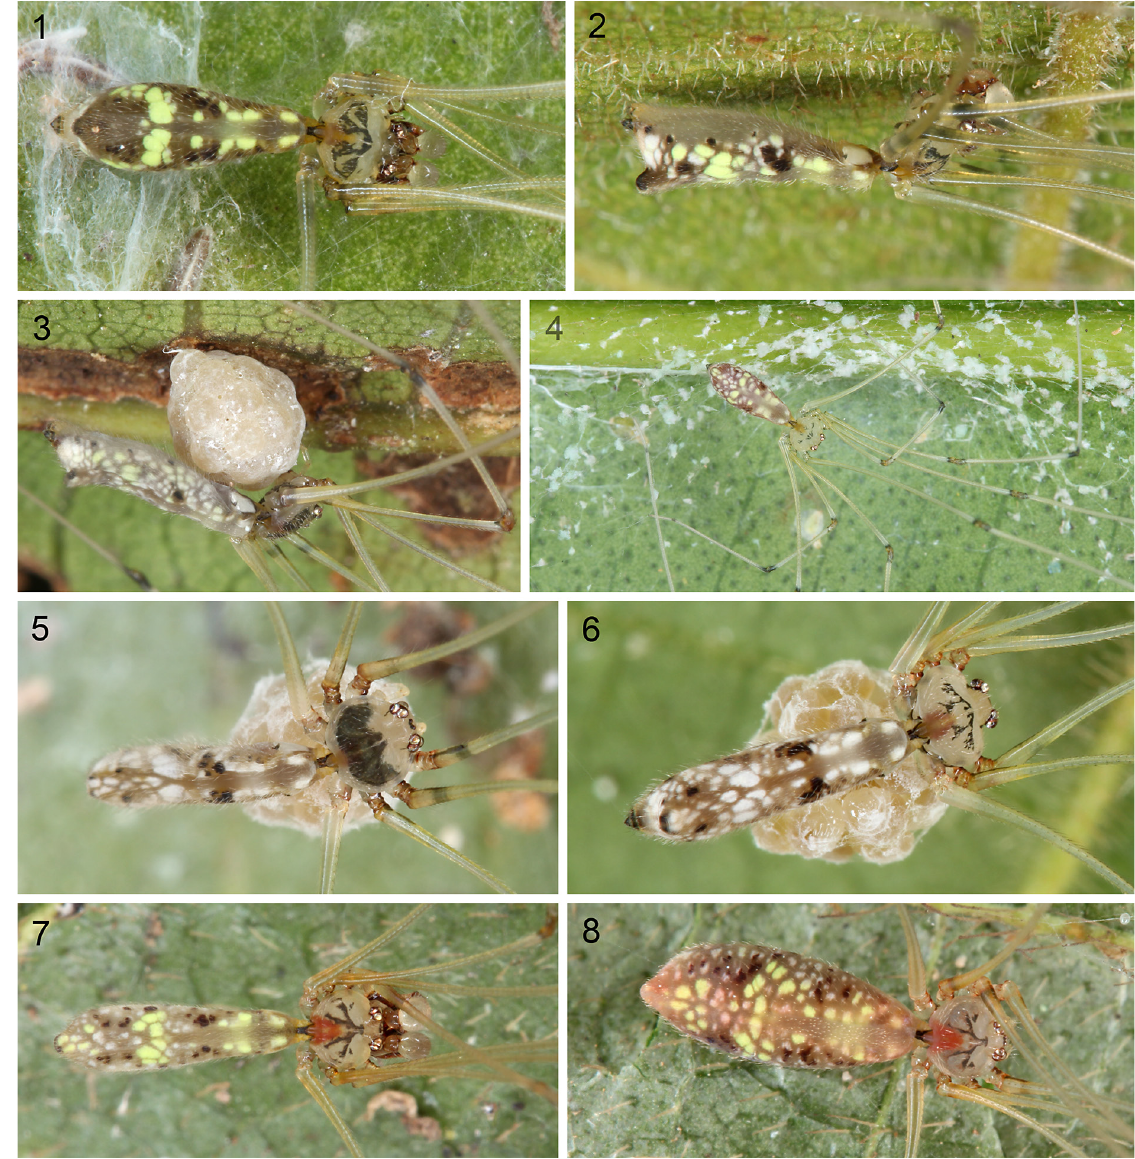
Figs 1–8. Live specimens, Pholcus halabala Huber, 2011 (1–6) and Ph. ubin Huber, sp. nov. (7–8). 1 . ♂ from MacRitchie, Singapore. 2 . ♂ from Gunung Jerai, Malaysia. 3 . ♀ with egg-sac from Gunung Liang, Malaysia. 4 . Juvenile in web with silk tufts, Upper Selatar, Singapore. 5 . ♀ with egg-sac from Hala Bala, Thailand. 6 . ♀ with egg-sac from Ulu Dong, Malaysia. 7–8 . ♂ and ♀ from Pulau Ubin,